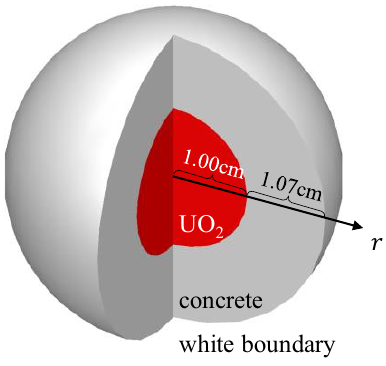
Figure 1. Cell Geometry and Boundary